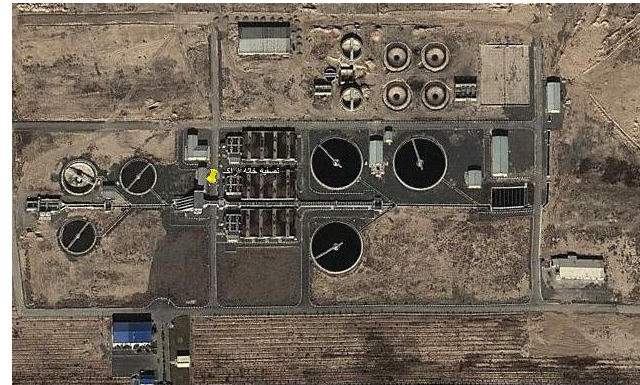
Figure 1. View of AWWTP with its unit processes Table 1. Annual average influent and effluent characteristics of Arak WWTP Concentration (mg/L) Removal Parameter